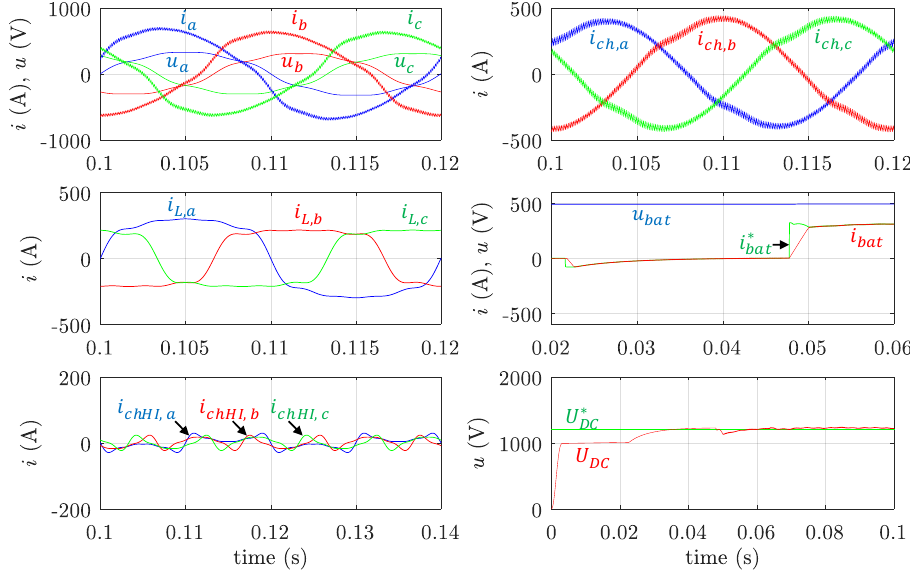
Figure 9. Simulation results. Case E. Charging the EV battery and injecting fundamental reactive power: 𝑃 ∗ = 158 kW and 𝑄 1∗ = 120 kVAr. CS demand with the same harmonic and unbalanced components as in Case D. 𝐼 𝐿𝑒 = 208.3 A. Table 7. Load, grid, and charge of the current harmonic and imbalance content for case E.